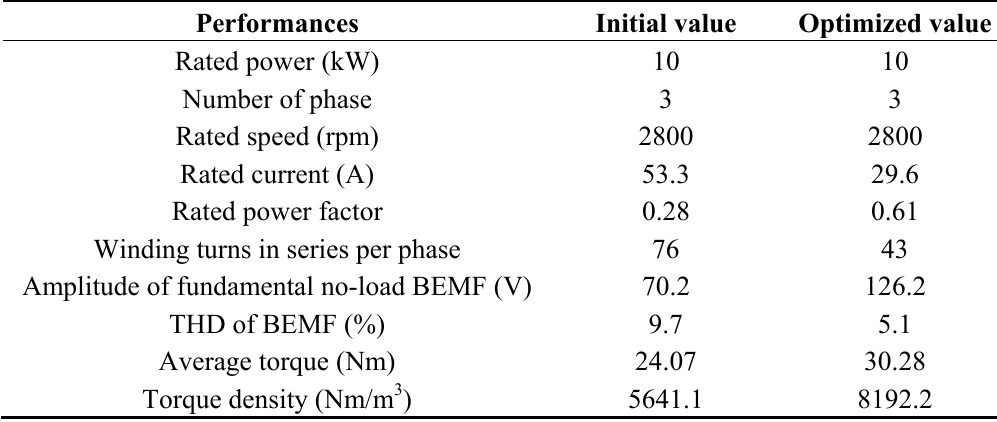
Table 2. Initial and Optimized Performances of the TFDRM.